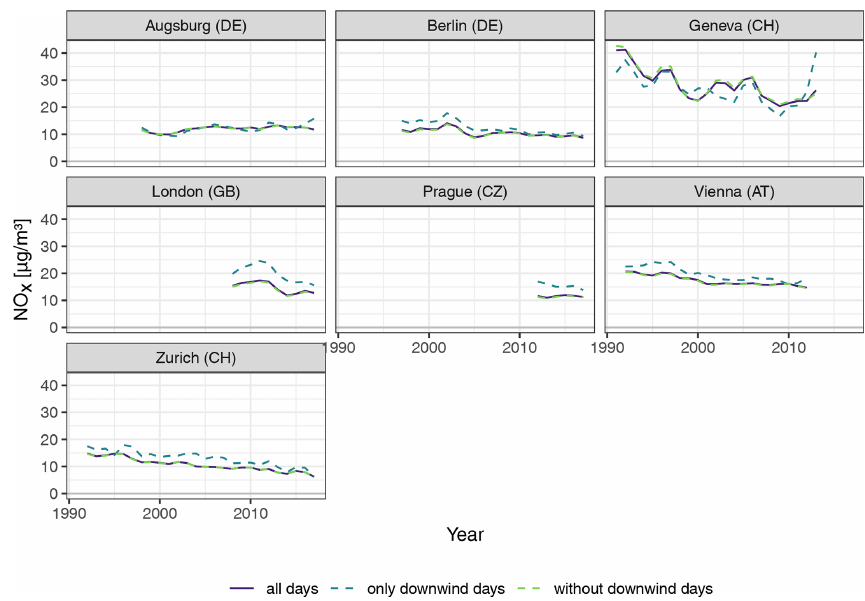
Figure 3. The influence of atmospheric transport of NO x from cities to rural background (RB) stations. The depicted mean RB levels are based on three different subsets of daily data that were filtered by wind directions. “Downwind days” refers to all days when the wind blew within a 30 ◦ range from the city to a RB